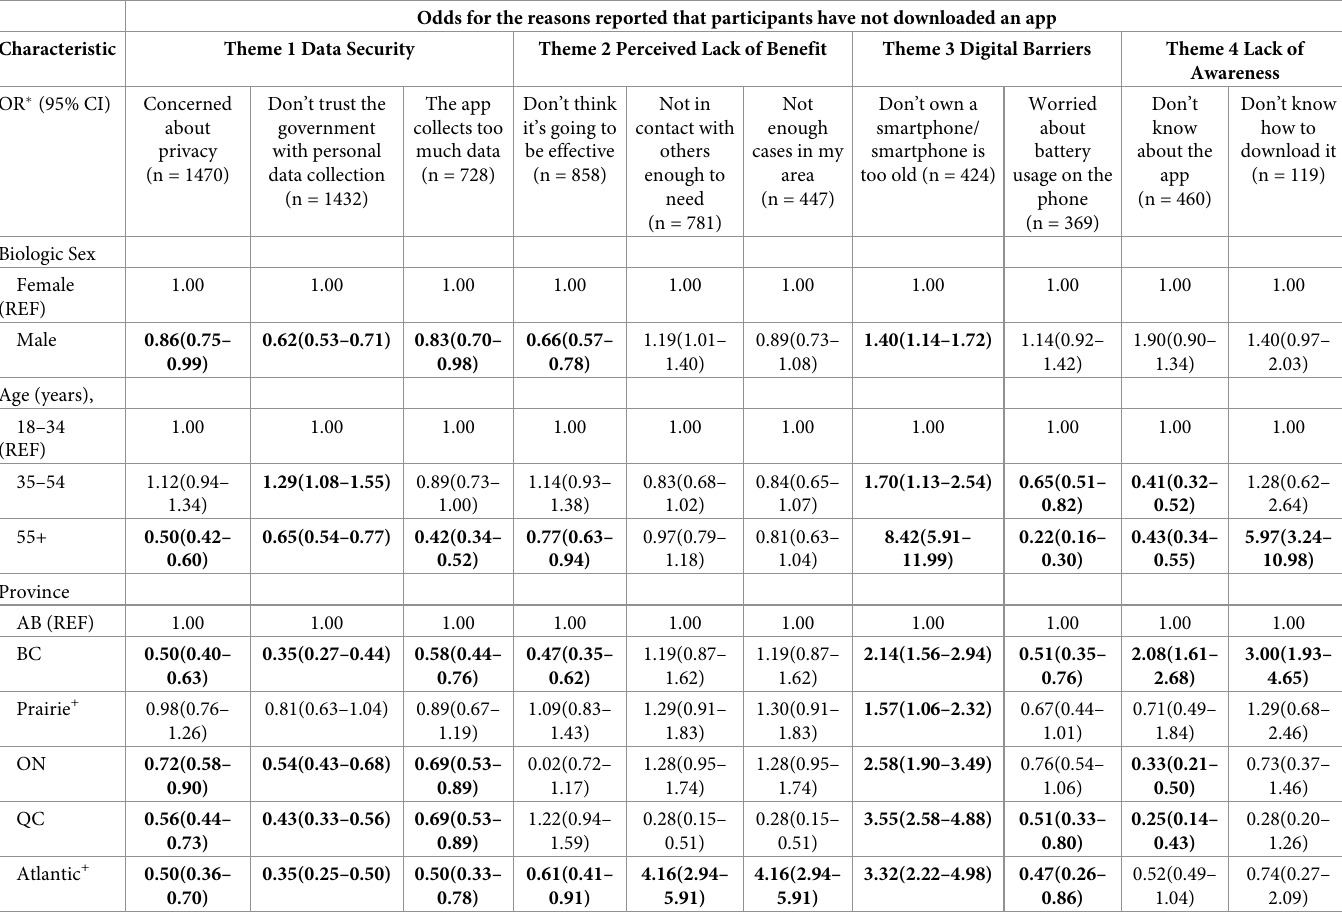
Table 2. Associations between demographic characteristics and reasons for not downloading an app. Participants could choose more than one reason. Odds for the reasons reported that participants have not downloaded an